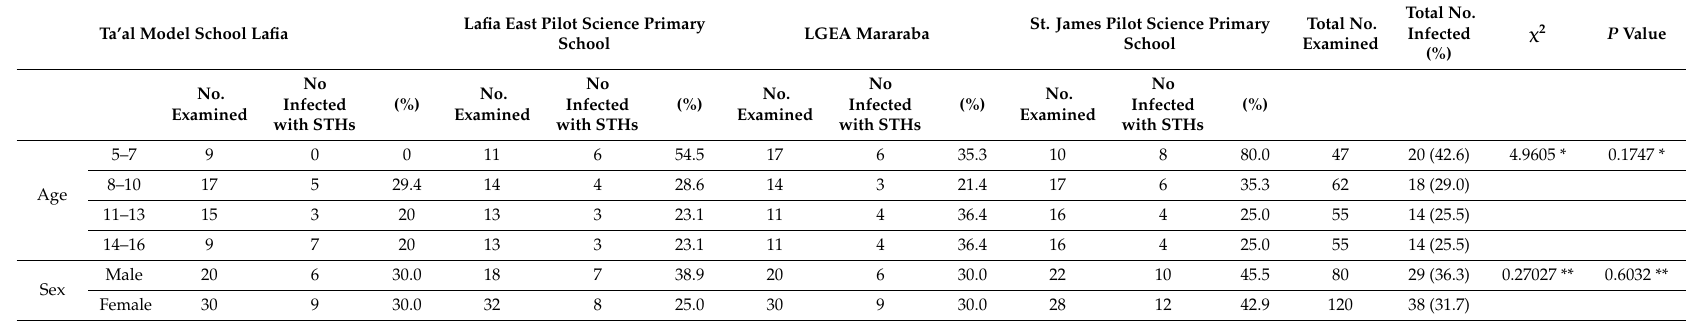
Table 1. Prevalence of soil-transmitted helminths (STHs) infection by age group and sex in the four selected public schools.